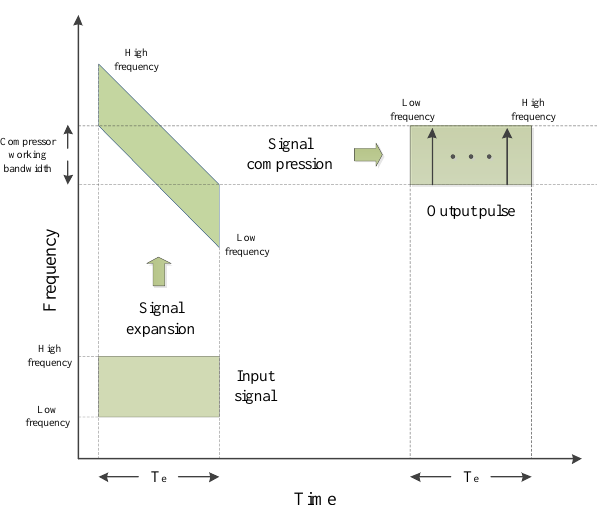
Figure 3. Schematic diagram describing the principle of the chirp transform spectrometer (CTS). The input signal shown in the left side is expanded to wide-band chirp signal by mixing it with the input chirp signal. Subsequently, the modulated chirp signal is compressed to a pulse though the SAW filter, which distributes on the time-domain shown on the right side.